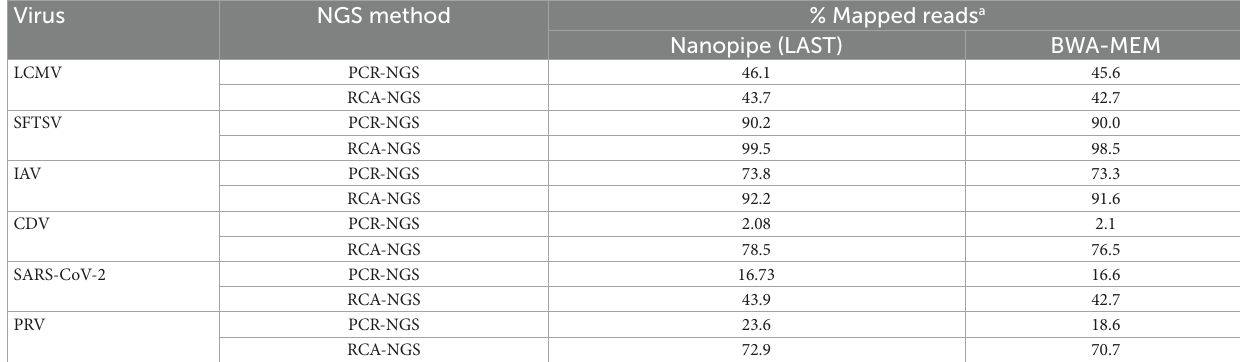
TABLE 5 Percentage of mapped reads in total mapped